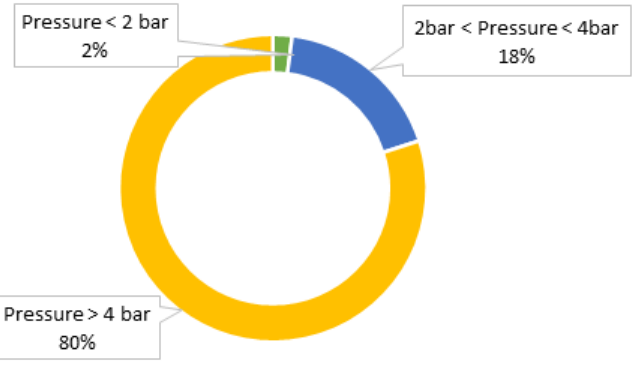
Figure 15. Percentage of ruptures (for the static scenario). Table 7. Annual volumes in the Gaula WDN.